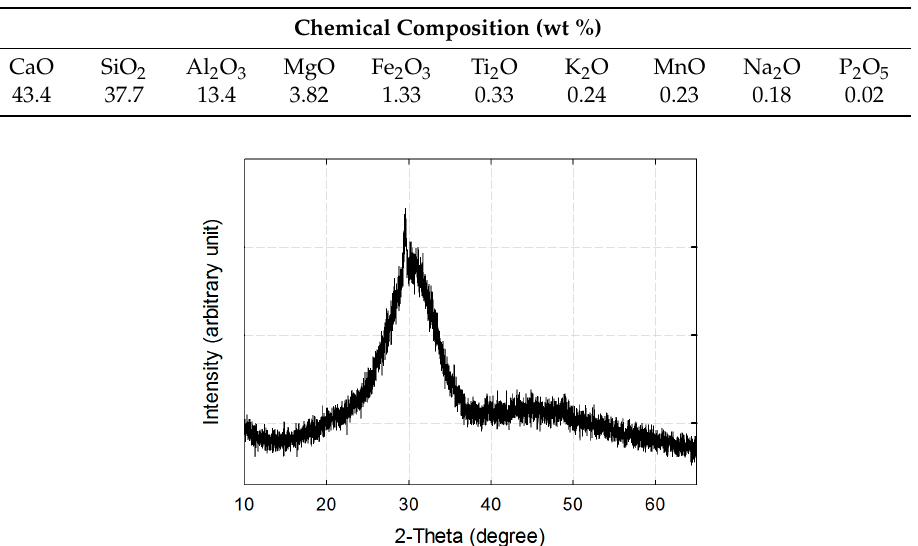
Table 1. Chemical composition of blast furnace slag.